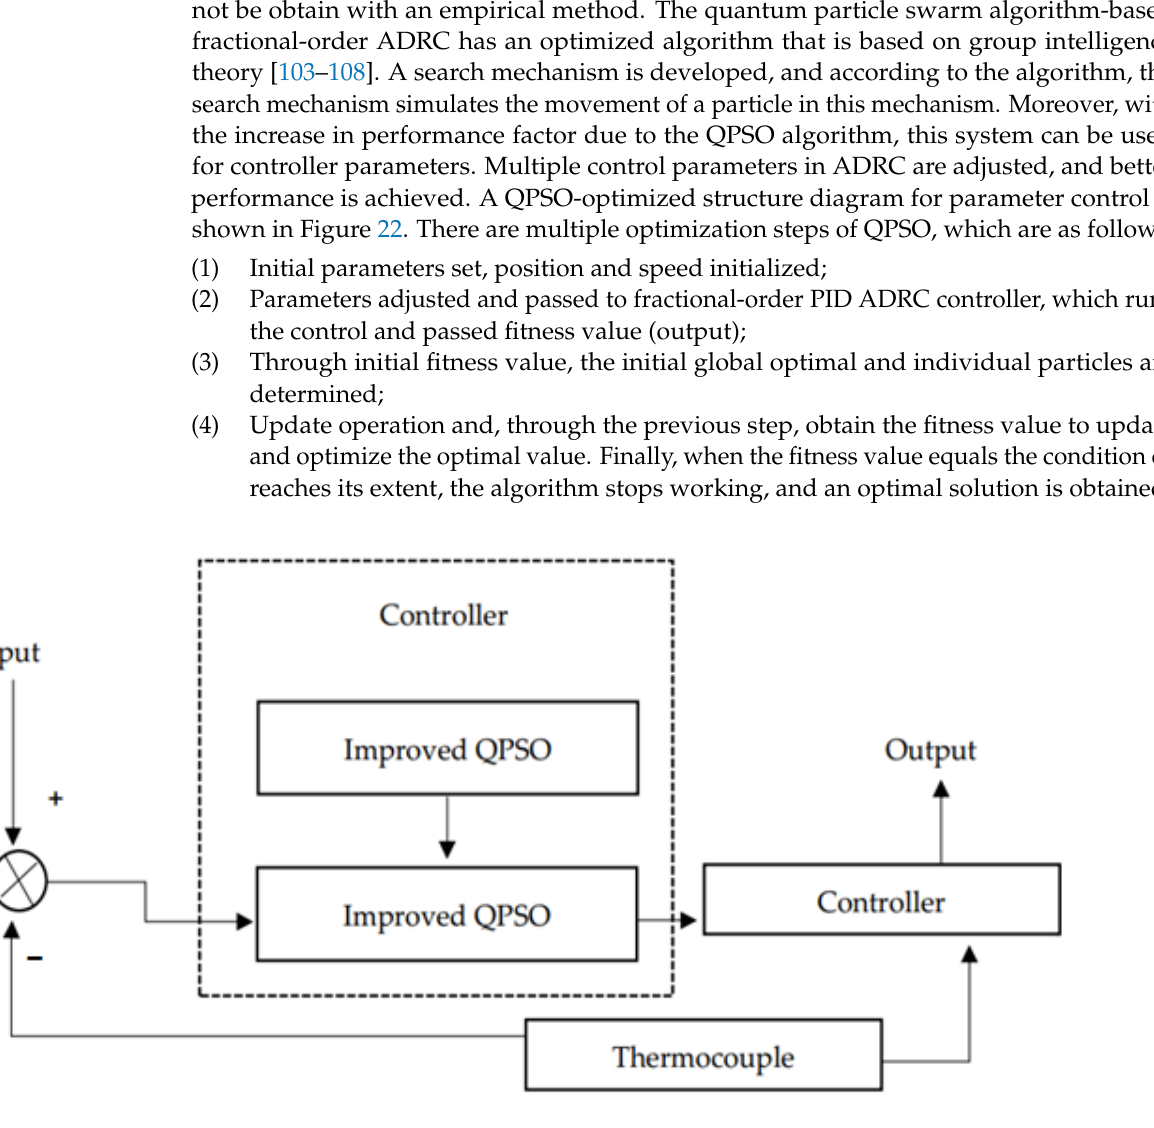
Figure 22. Flow Diagram of QPSO parameter optimization algorithm [103].